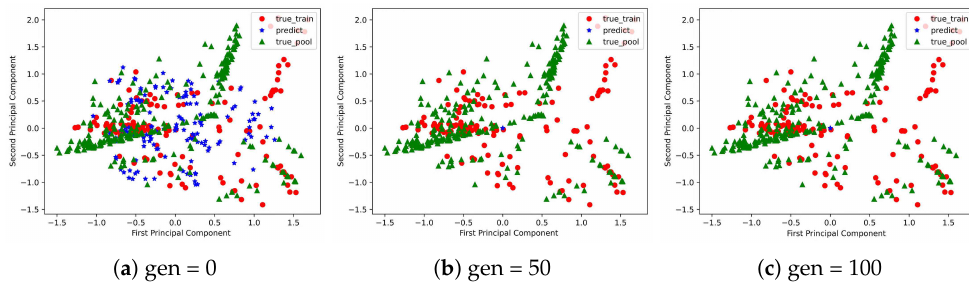
Figure 10. Population evolution of MPUSMs-IMFEOA based on the DRBM-Social surrogate model.